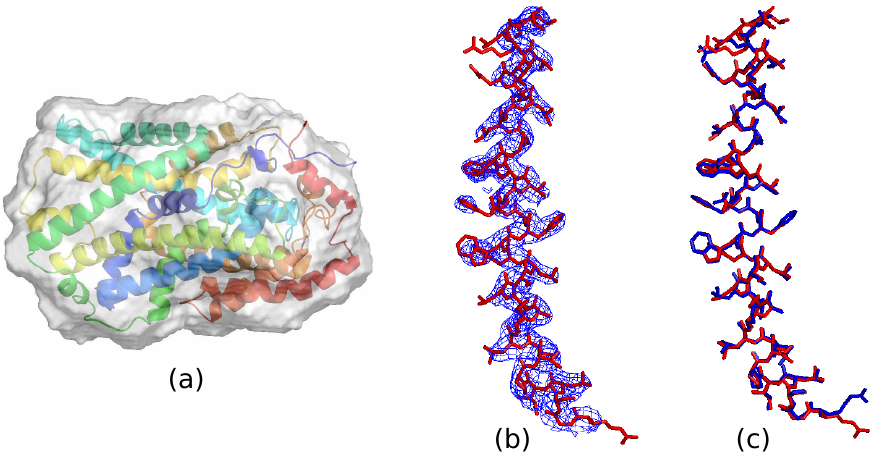
Figure 3. ( a ) The calculated protein boundary, ( b ) density map, and ( c ) reconstructed model (shown as blue sticks) of 2JLN using 2.85 Å observed data. The PDB deposited model is superimposed and shown as cartoons in ( a ) and as red sticks in ( b , c ). Only one major helix is shown in ( b , c ) for